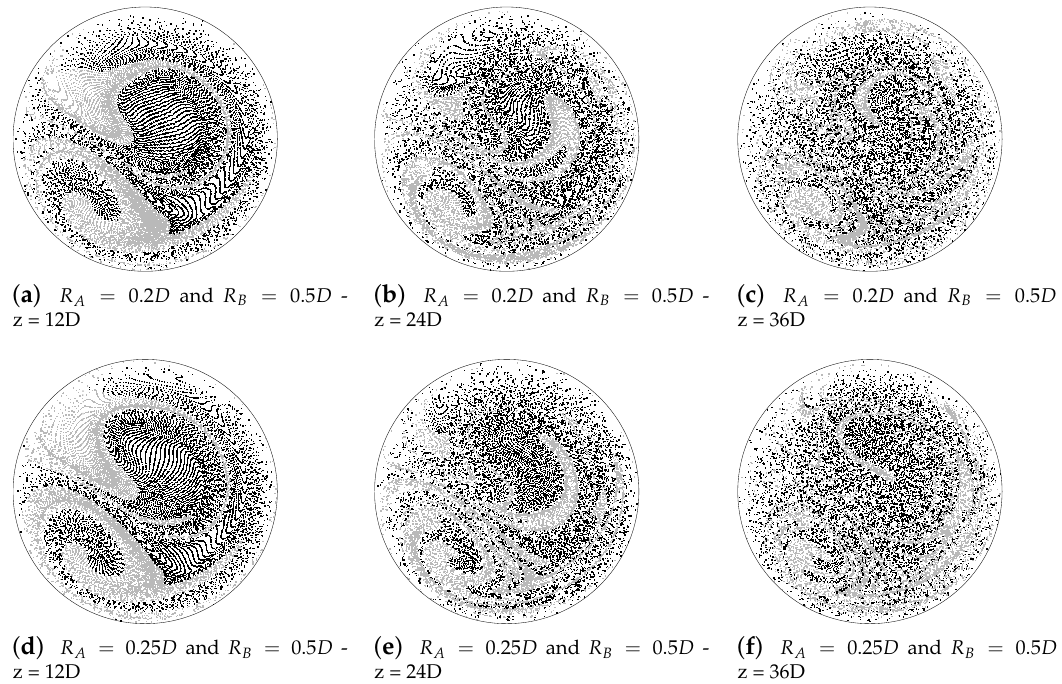
Figure 12. Particle trajectory slices obtained from particle tracking performed on the velocity field directly computed over the entire combined